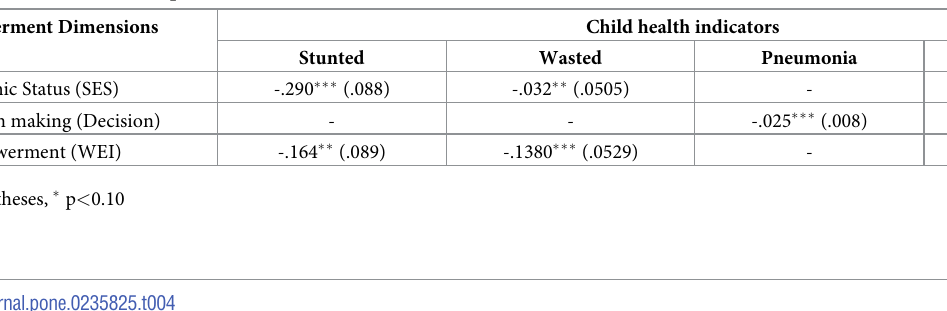
the marginal effect of the decomposed empowerment dimensions as well as the composite women’s empowerment index that are significantly associated with children’s health status. The results show that women’s socio-economic empowerment dimension is associated with a 26.3% (p < 0.001) (prediction in the probability of being stunted (height-for-age Z-score) and a 3.24% (p < 0.05) reduction in the probability of being wasted (weight-for-height Z-score). This shows that women’s empowerment regarding their socio-economic status has a higher associa- tion on stunting than wasting. This result is in congruence with previous studies on the effect of socioeconomic status on stunting and wasting [32,69]. For non-anthropometric dimen- sions, the result shows that higher empowerment with regard to women’s household decision making is associated with a 2.5% (p < 0.001) reduction in the probability of having pneumonia and a 10% (p < 0.001) decrease in the probability of being anemic for the children. This may imply that women’s higher decision-making power has a significant effect on children’s health status. Since women’s decision making was not significant for the child’s health status indi- cated by being wasted and/or stunted, their marginal effect is not calculated. Based on the mar- ginal effects of the composite women’s empowerment index, a one unit increase in the women’s empowerment is associated in a reduction by16.4% probability of being stunted and a reduction by 13.80% probability of being wasted. After the estimation of the Generalized SEM MIMIC model, we evaluated the goodness of fit of the various model specifications using the Akaike Information Criterion (AIC) and Bayesian Information Criteria (BIC). Since other goodness of fit indices are not available under Generalized SEM responses, we use these fit indices to compare the different specifica- tions of MIMIC models. Smaller AIC and BIC values indicate a better fit model. In this case, model 2 for both anthropometric and non-anthropometric health indicators show a good fit model as compared to the other model specification (See Table 5) below.